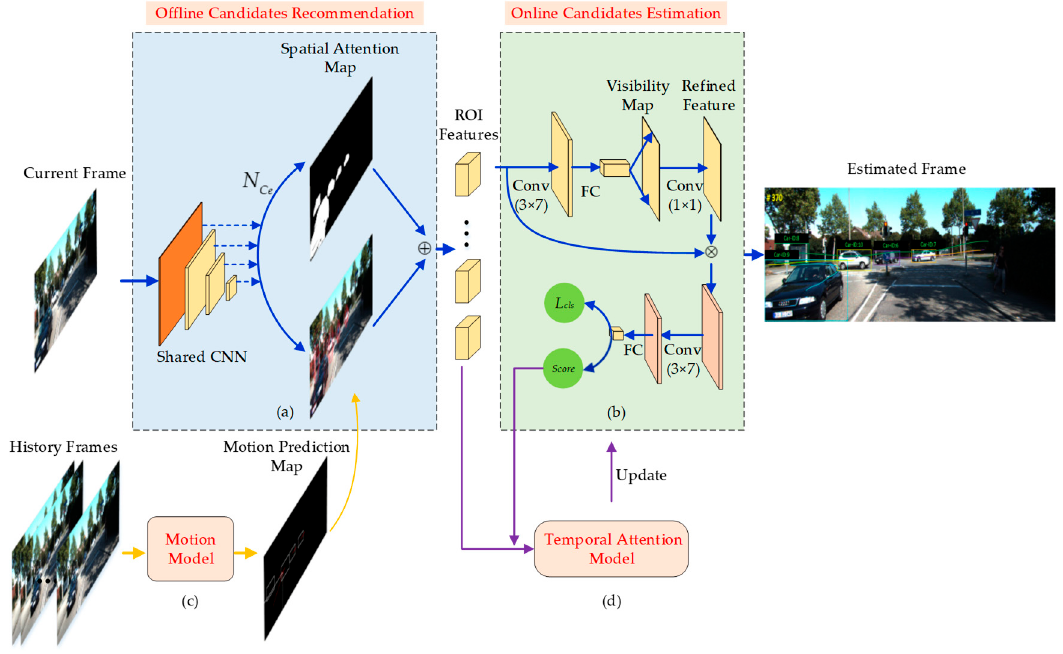
Figure 2. Overview of our method. ( a ) Offline Candidates Recommendation Module; ( b ) Online Candidates Estimated Module; ( c ) Motion Model; ( d ) Temporal Attention Model. ⨁ demotes combination.